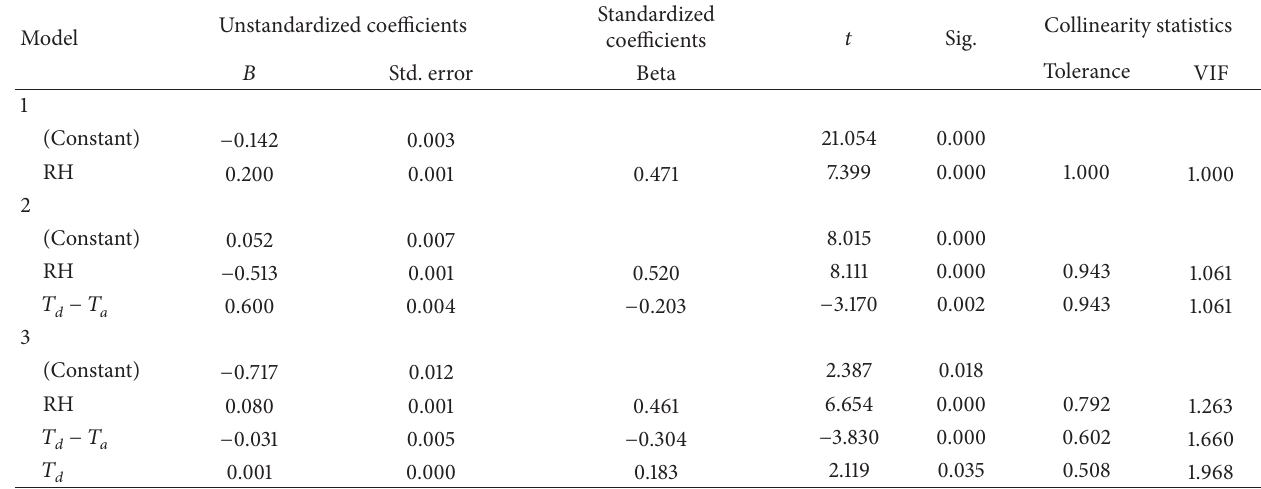
Table 3: Coefficients of dependent variable (dew intensity).